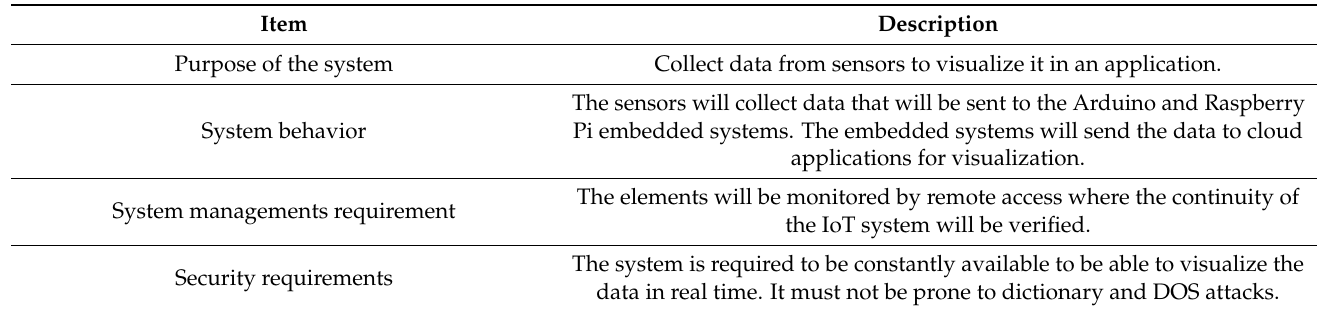
Table 12. Case study purposes and requirements.